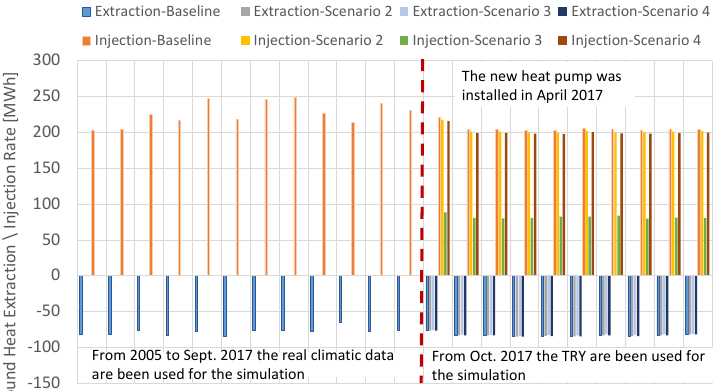
Figure 6. Mean monthly outlet fluid temperature from the borehole heat exchangers: measured values from 2006 to 2017; simulated values in ( a ) Scenario 1 , ( b ) Scenario 2 , ( c ) Scenario 3 , ( d ) Scenario 4 .